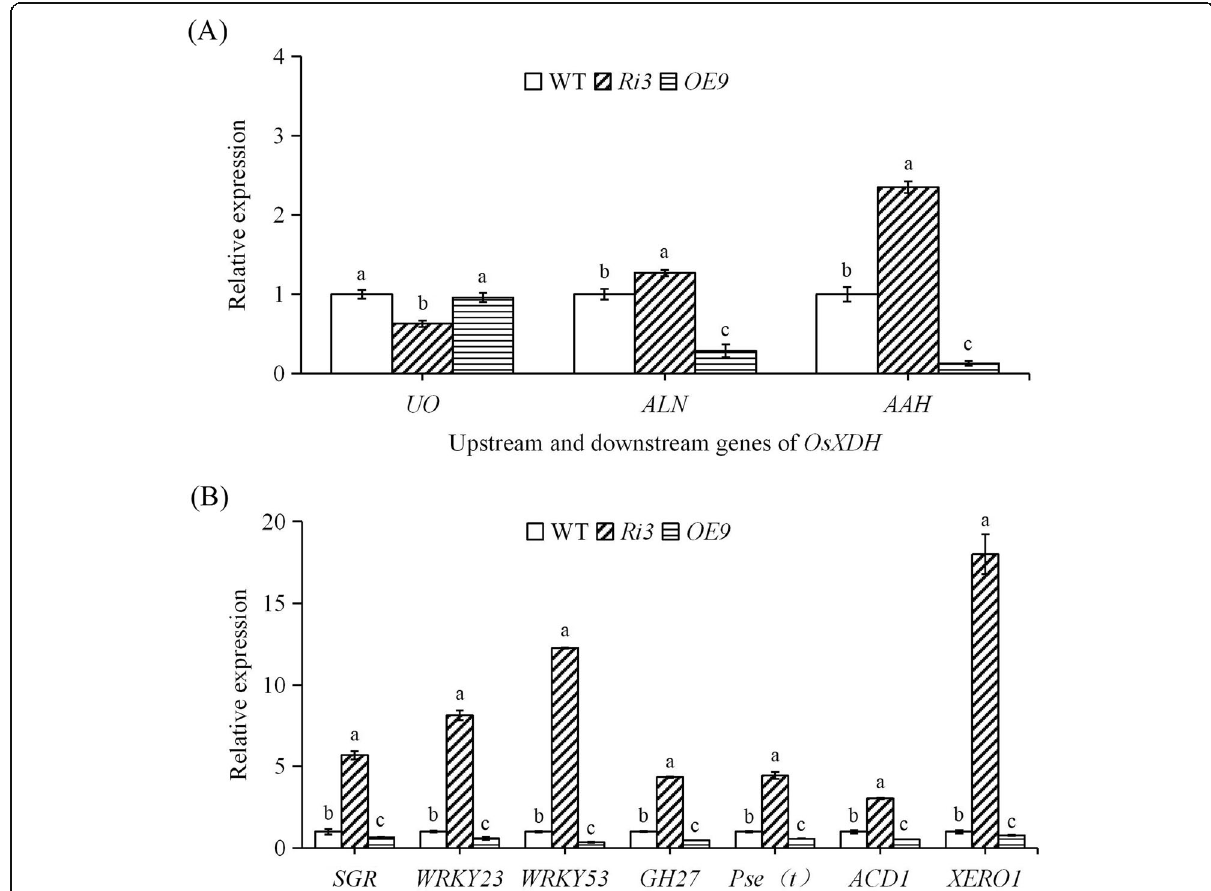
Fig. 7 Expression analysis of genes upstream and downstream of OsXDH and of senescence related genes at the maturation stage. The maturation stage of rice were grown to 90d after sowing. Sword leaves are selected for the determination of expression of upstream- downstream genes of OsXDH ( a ) and leaves senescence related genes ( b ) at maturation stage. Ubi2 served as an internal control. Values are means±SEM, n = 3. Significant differences ( P < 0.05) are denoted by different lowercase